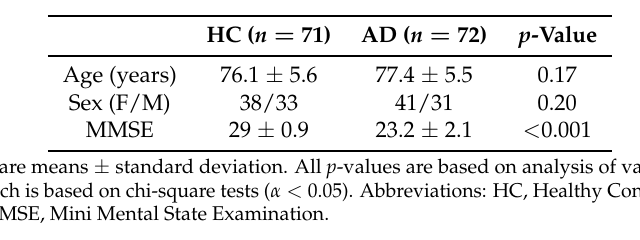
Table 1. Demographic and clinical characteristics of the study